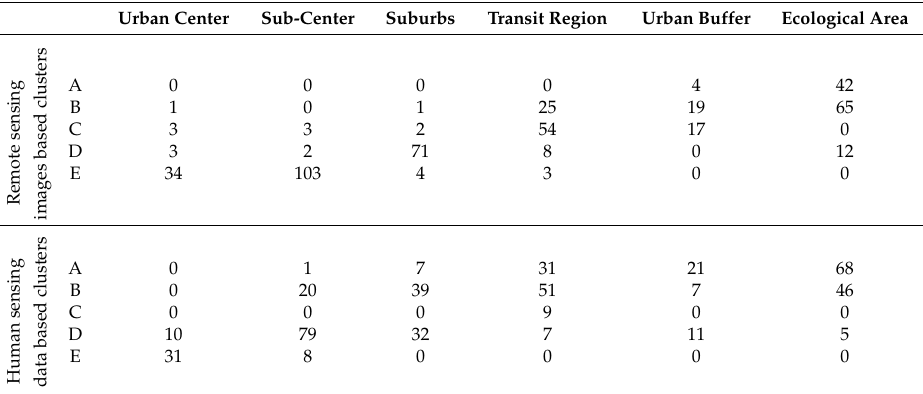
Figure 13. Cluster result with landscapes: ( a ) the dendrogram; ( b ) clustering map. Table 4. The comparison of different clustering results.